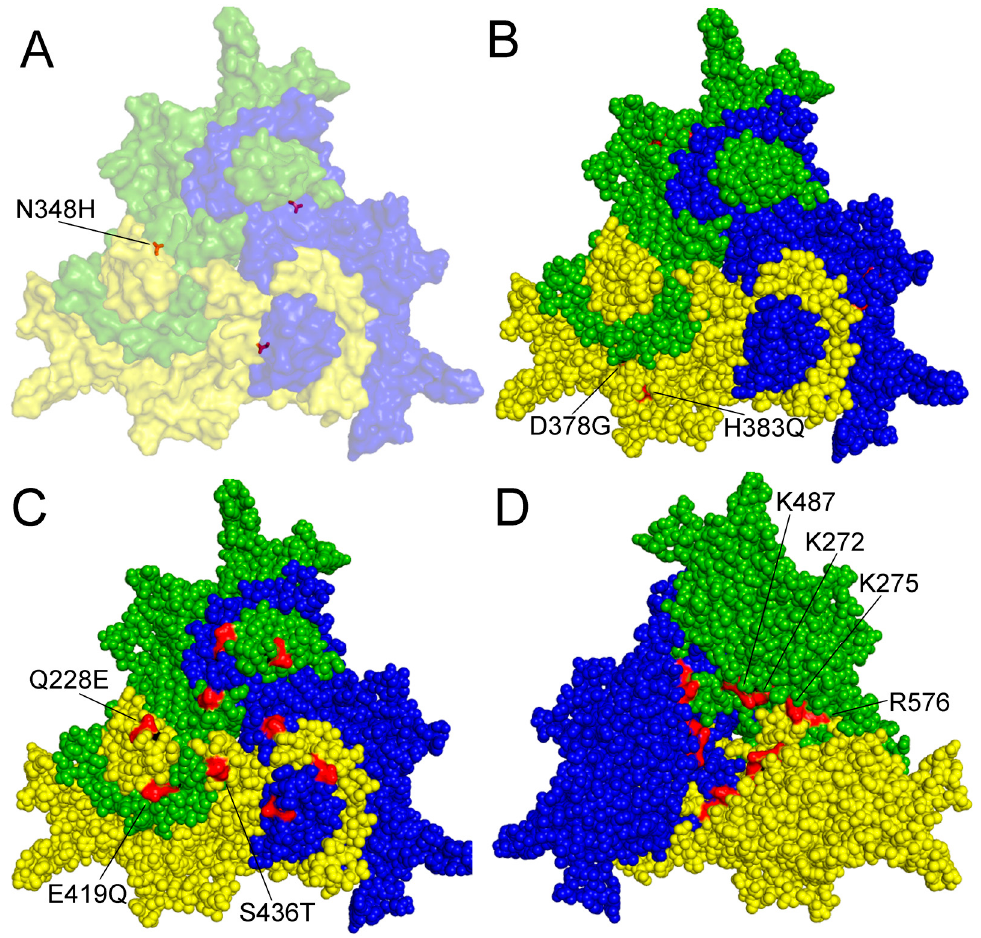
Figure 2. Amino acid residues with known function on the surface of a capsid protein 2 (VP2) trimer of PPV. A–C outer surface is shown. ( A ) amino acid (aa) 348 highlighted contributing to P2 replication in the canine cell line A72; ( B ) aa 378 and 383 are involved in tissue tropism and probably in virulence; ( C ) aa 228E, 419Q and 436T are characteristic of the members of the D cluster; ( D ) aa K272, K275, K487 and R576 form a nuclear localization motif on the inner surface of the trimer. Numbering is presented according to NADL-2 VP2 sequence, amino acid changes labeled by commonly used colloquial nomenclature. Trimer was generated by Viper program and visualized by Polivew.